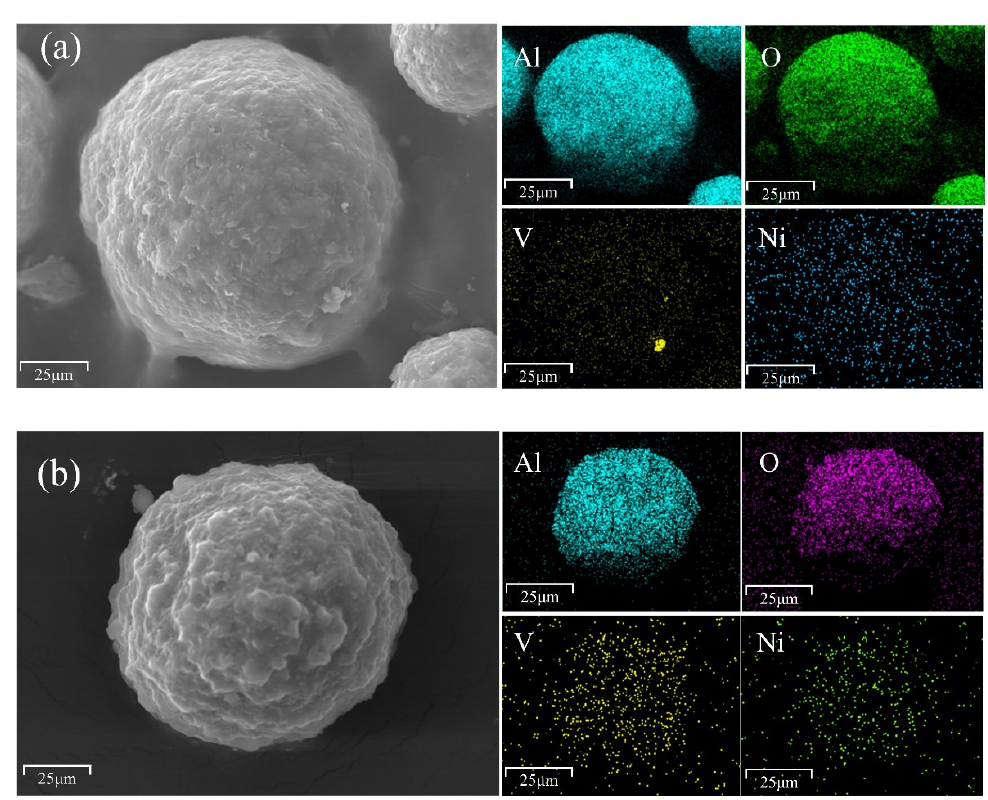
Figure 1. SEM images and EDS spectra of the ( a ) fresh and ( b ) SFCC catalysts.